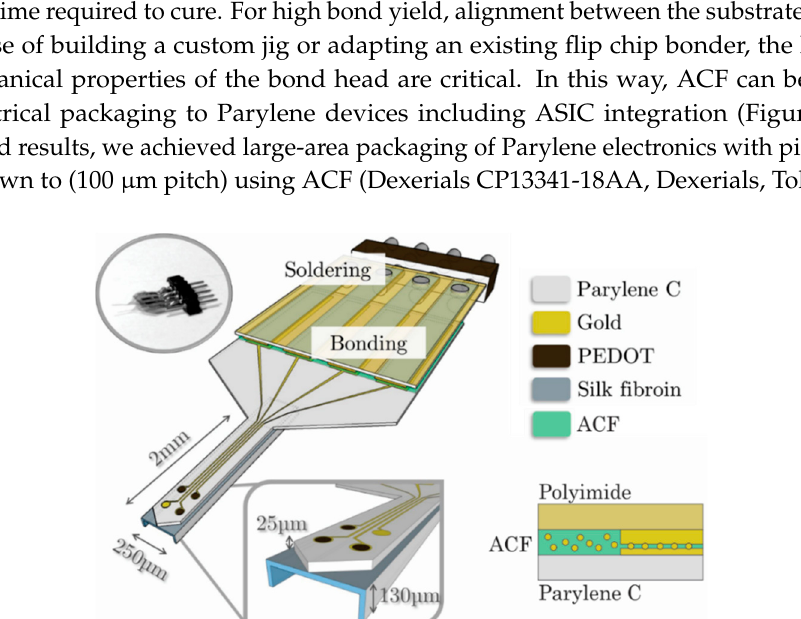
Figure 9. Holes left by gold removal during ultrasonic wire (ball) bonding on a gold thin film on Parylene substrate.